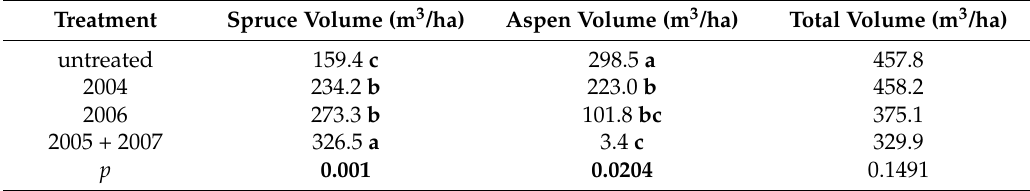
Table 9. Merchantable volume of aspen and spruce (30 cm stump, 13 cm minimum DBH (Diameter at 1.3 m height), and 10 cm minimum top diameter) at age 90 for each treatment based on Mixedwood Growth Model (MGM) simulations run for each plot. Where Analysis of Variance indicates significant treatment effects ( p < 0.05), bold letters are used to indicate differences between treatments determined using Tukey’s LSD